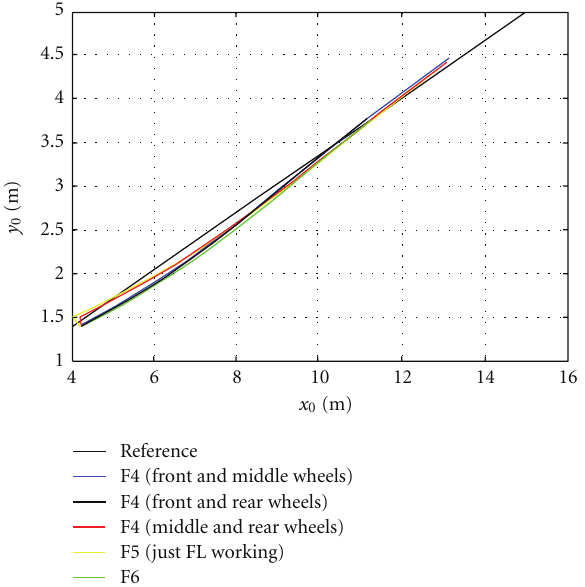
Figure 22: Simulation of cases F4 to F6 with control reconfigura-